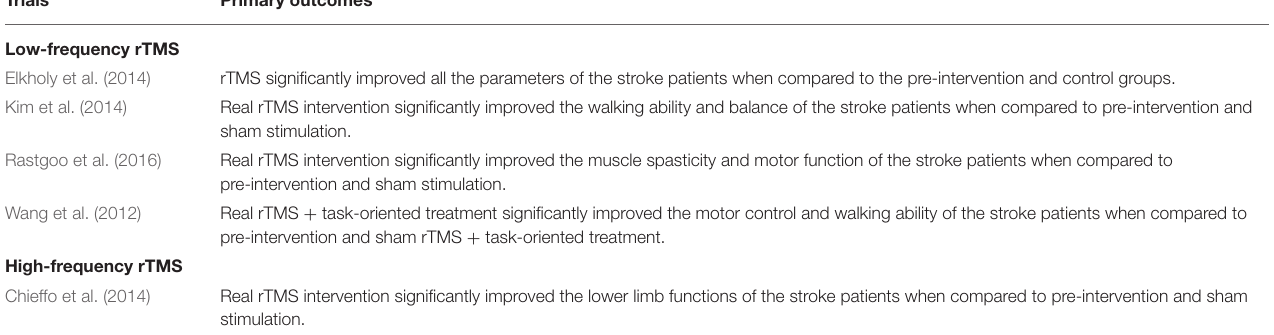
TABLE 3 | The primary outcomes of the included studies. Trials Primary